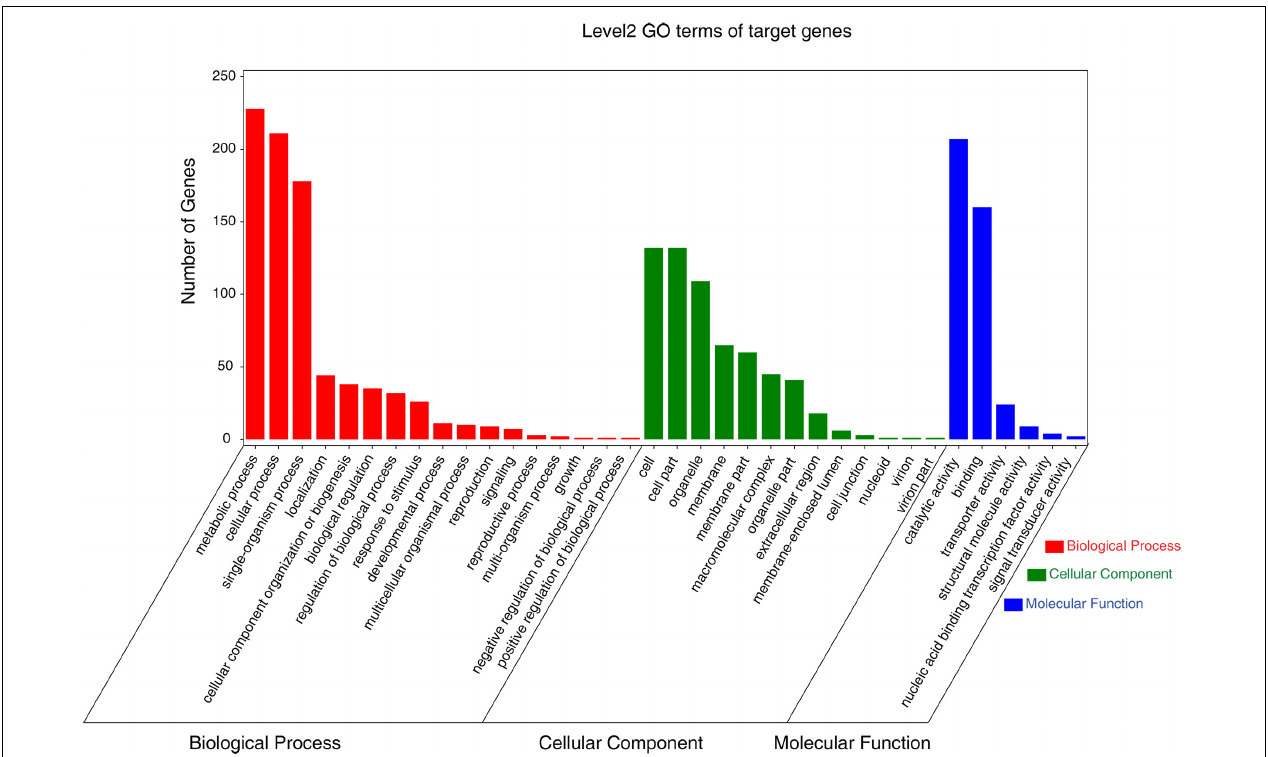
FIGURE 5 | Gene ontology (GO) analysis of the predicted targets of differentially expressed miRNAs and most abundant biological process (red), cellular component (green), and molecular function (blue) GO